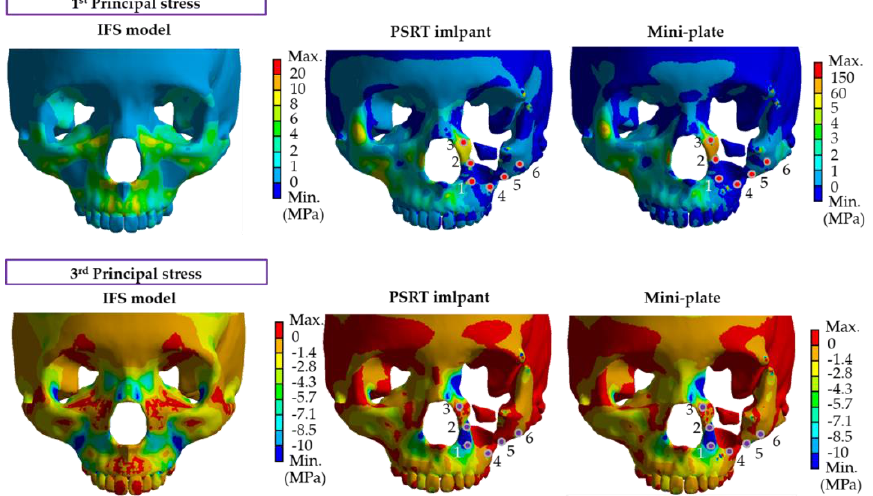
Figure 8. The stress distribution of the intact skeleton bone, the ZMC fracture repairing with the PSRT implant and traditional